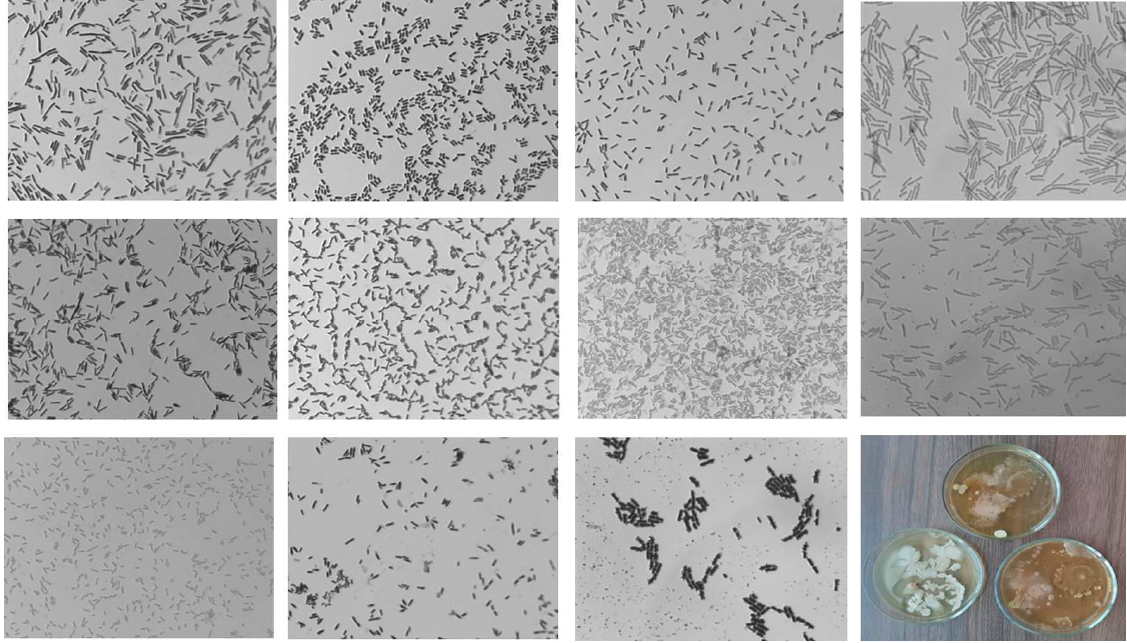
Figure 4. Photo of bacteria sown from potato tubers treated with Se/ST NC (1000× zoom).